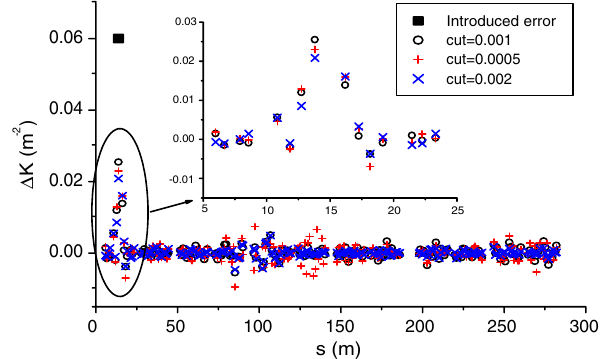
FIG. 9. Fitted quadrupole corrections from LOCO for various SVD cuts. The quadrupole correction, without the intentionally introduced error, is subtracted. A response from the neighboring quadrupoles is observed. The identification is improved by lowering the cut from 0.002 to 0.001 while a further reduction to 0.0005 results in no improvement but unwanted quadrupole corrections.